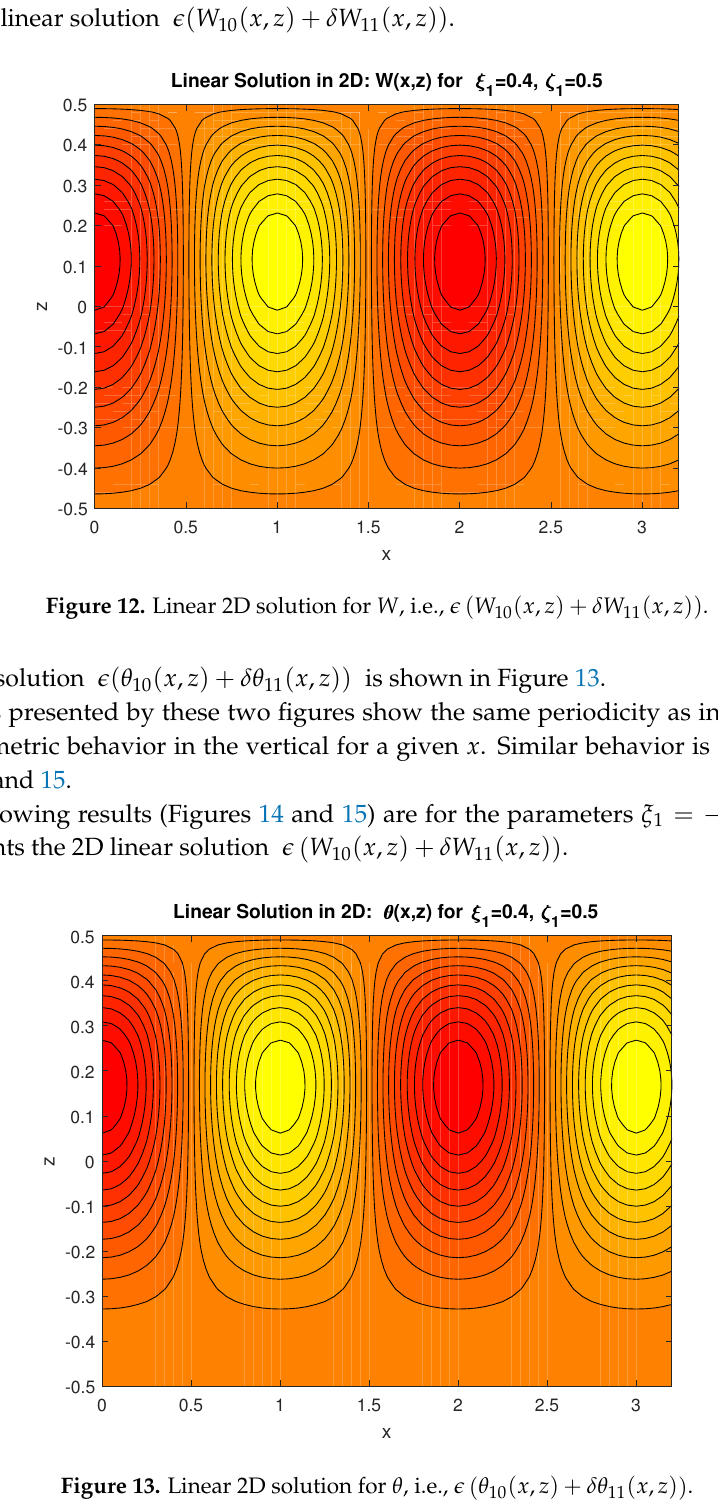
Figure 13. Linear 2D solution for θ , i.e., (cid:101) ( θ 10 ( x , z ) + δθ 11 ( x , z ))